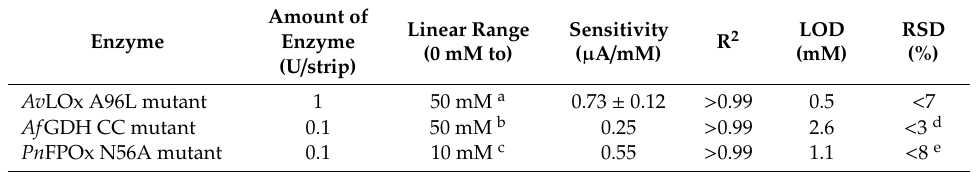
Table 1. Properties of biosensors employing 1-methoxy-5-ethyl phenazinium ethyl sulfate (mPES) in this study.